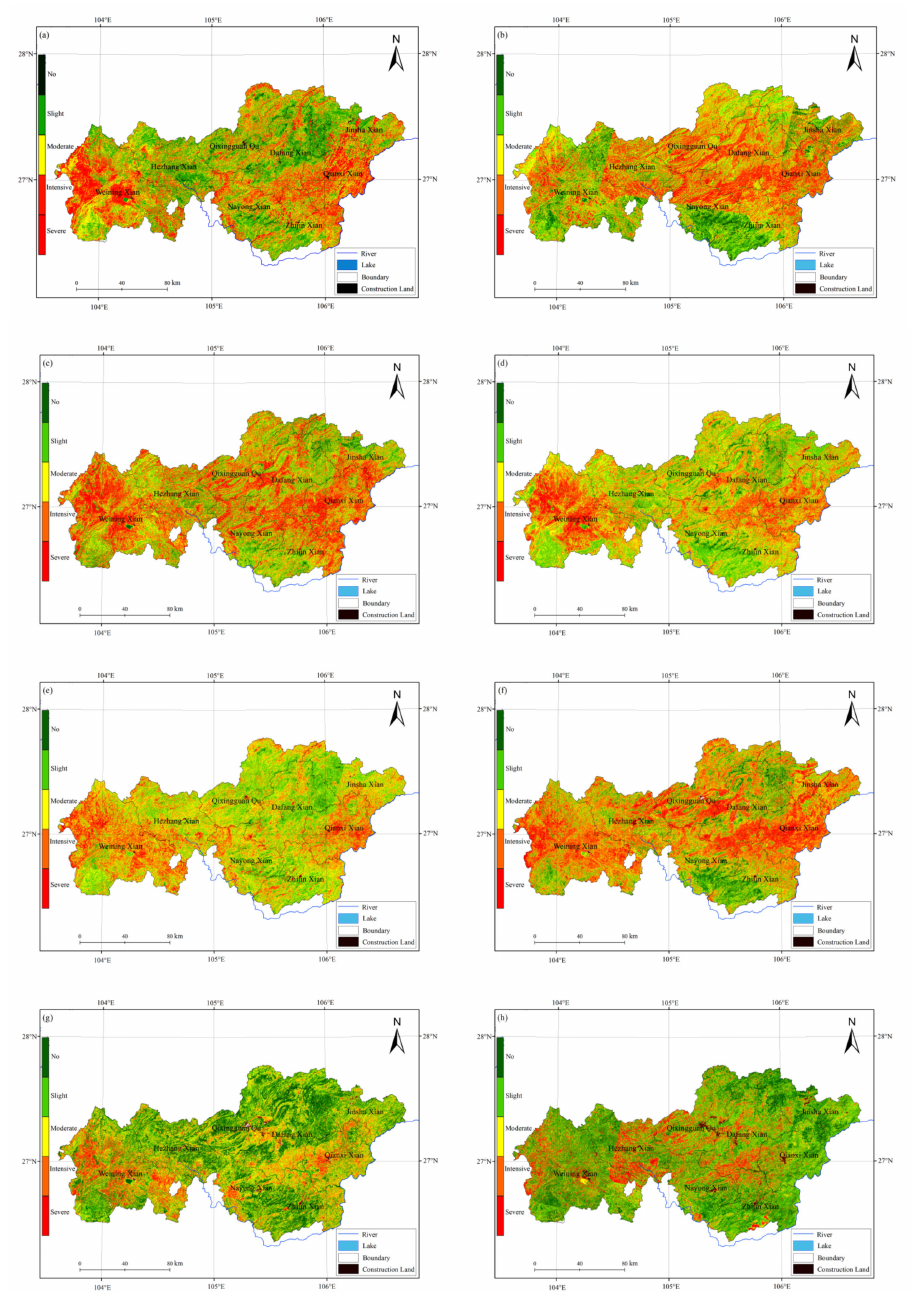
Figure 6. Spatial distribution of rocky desertification in different historical periods: ( a ) 1985, ( b ) 1990, ( c ) 1995, ( d ) 2000, ( e ) 2005, ( f ) 2010, ( g ) 2015, ( h )